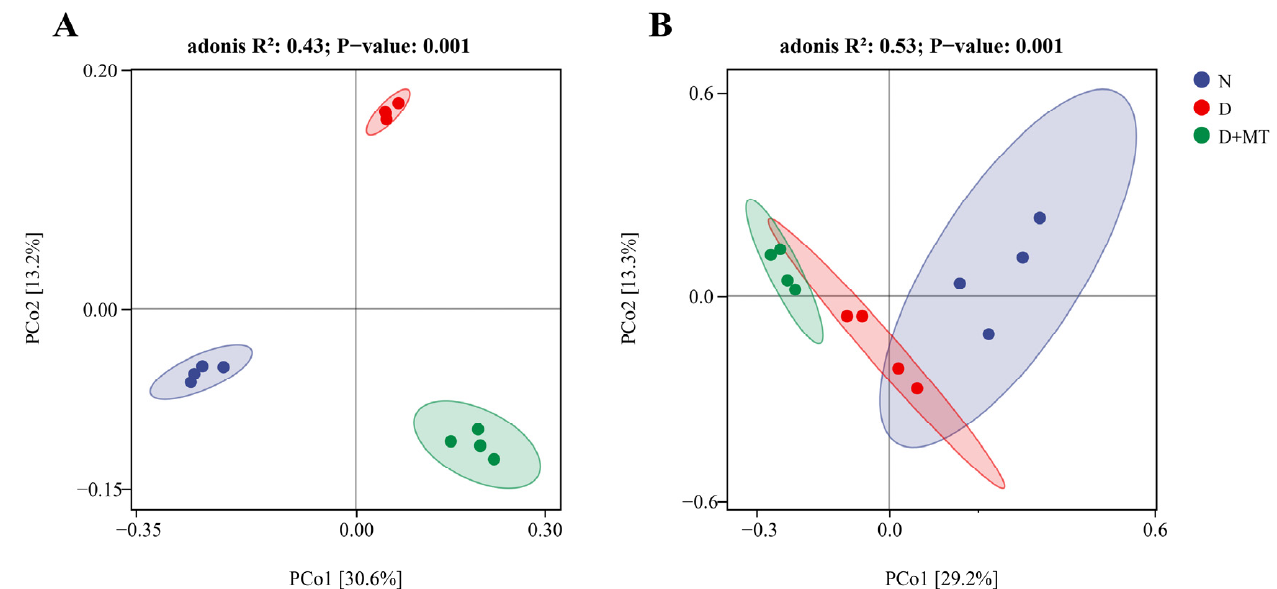
Figure 5. PCoA (Principal Co-ordinates Analysis) of Bray–Curtis distances ( p < 0.05) for bacterial ( A ) and fungal ( B ) communities under the combination of melatonin treatment and drought stress. N, normal control; D, drought stress; D + MT, melatonin + drought stress.